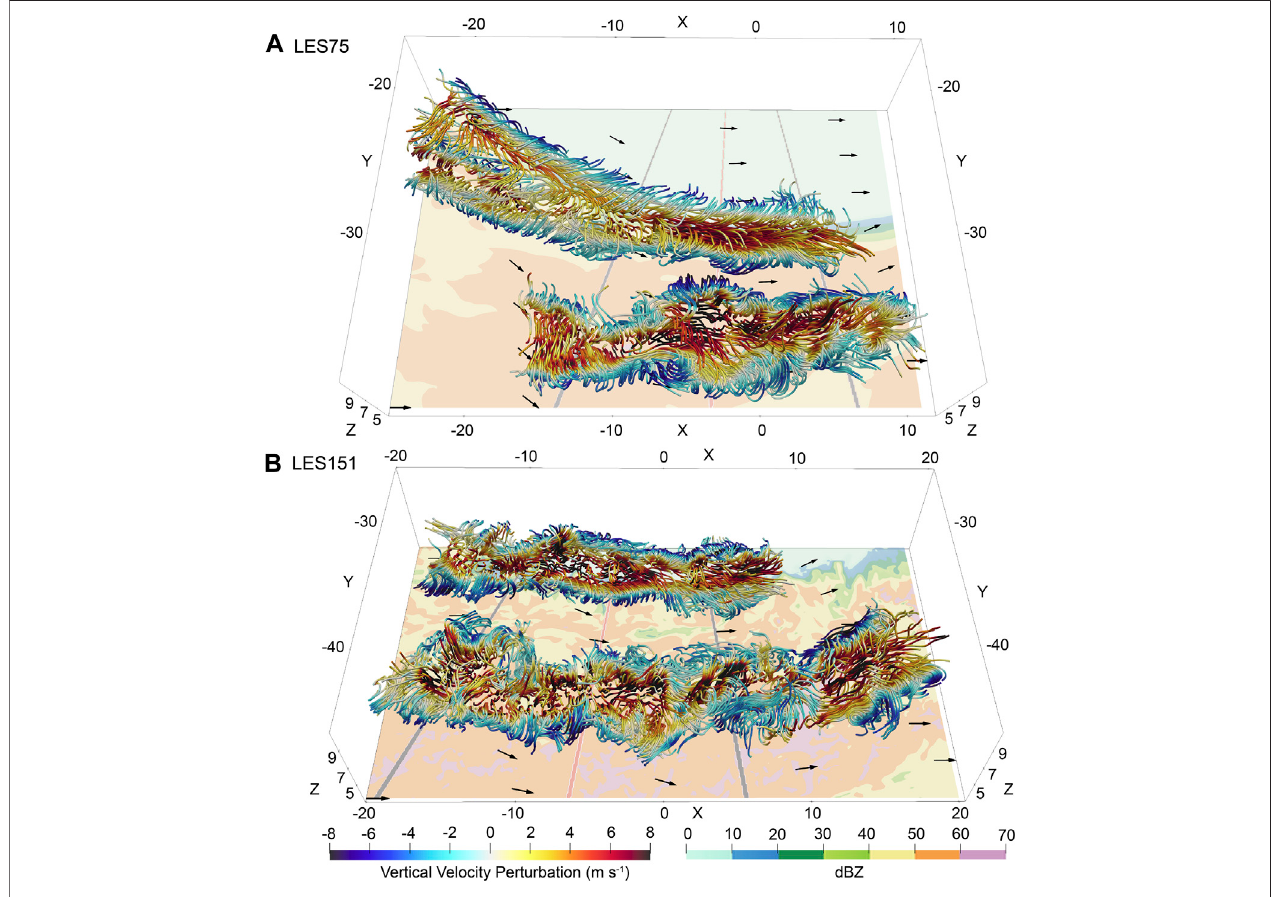
FIGURE 4 | The perturbation winds (three-dimensional streamlines), 7 km horizontal winds (vectors), and 7 km radar re fl ectivity (shading) at 0300 UTC 18 July in LES75andat0400UTC18JulyinLES151.Thestreamlineswithwarmandcoolcolorsindicatetheupwardanddownwardmotion,respectively.Theredandblacklines indicate the position of the cross section in Figures 3A,B and the azimuthal range of the cross sections in Figures 3C,D , respectively.